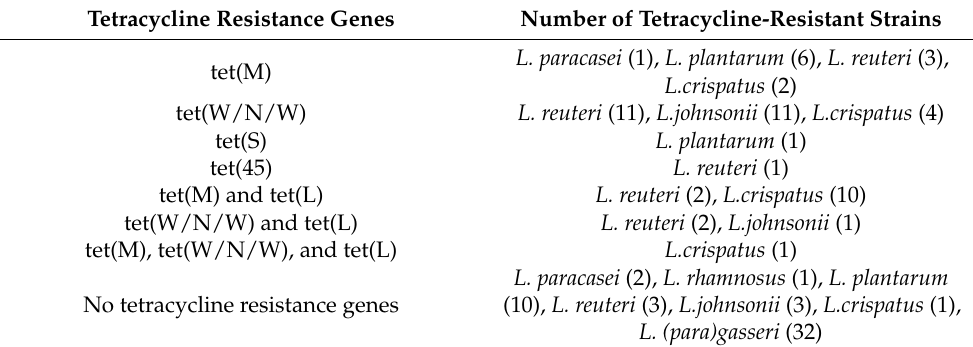
Table 1. Association between tetracycline-resistant strains and tetracycline resistance genes in eight lactic acid bacterial species.